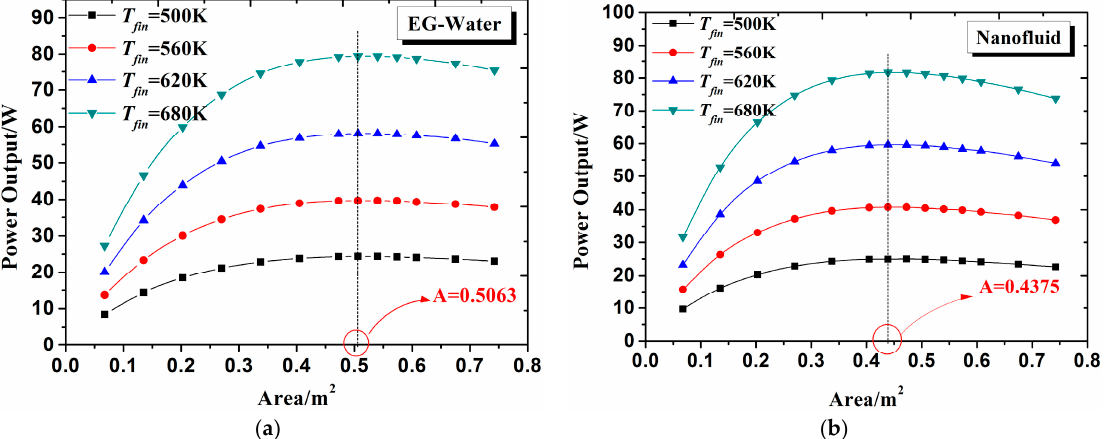
Figure 6. Power output variations with total area of TEMs for Cu-EG nanofluid and EG-W coolant: ( a ) EG-W coolant; ( b ) Cu-EG nanofluid coolant.